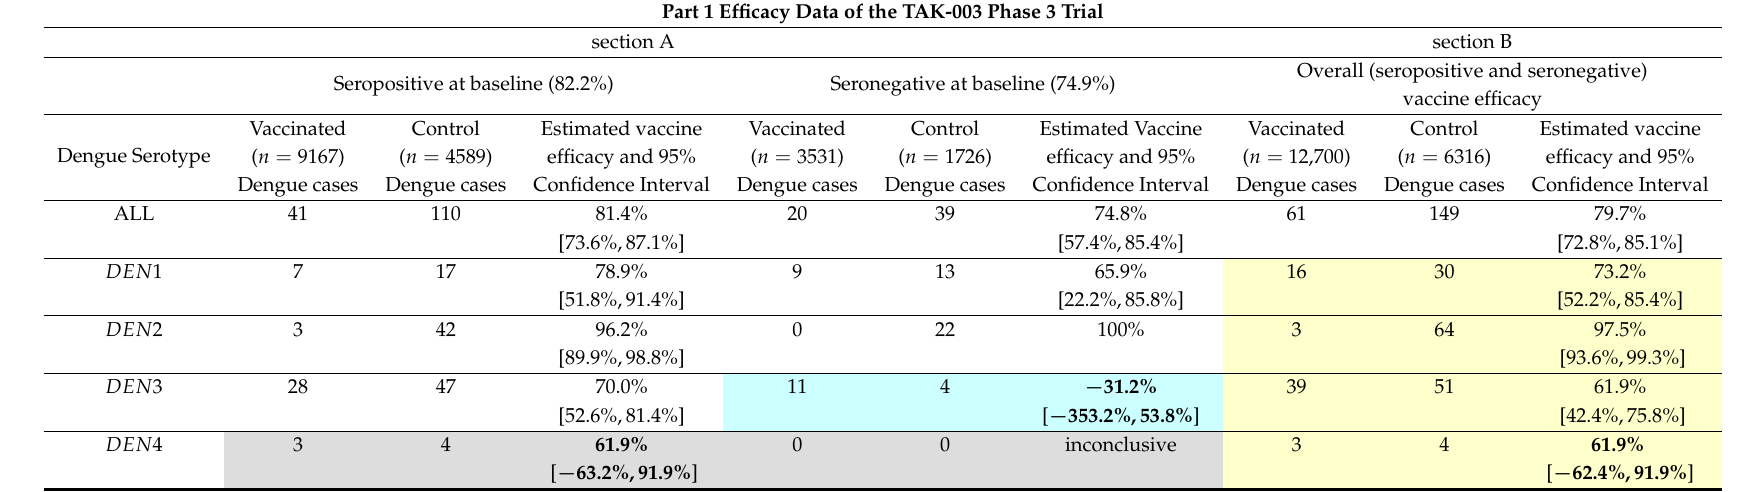
Table 1. Compilation of vaccine efficacies estimation for Takeda’s DENVax vaccine phase 3 trial post-vaccination surveillance period part 1 (12 months). Section A shows the vaccine efficacies by serostatus and serotype, and Section B shows the overall vaccine efficacy by serotype. Highlighting problems observed for serotypes 3 (blue) and 4 (grey) are indicated. The raw data used for the Bayesian analysis are available in